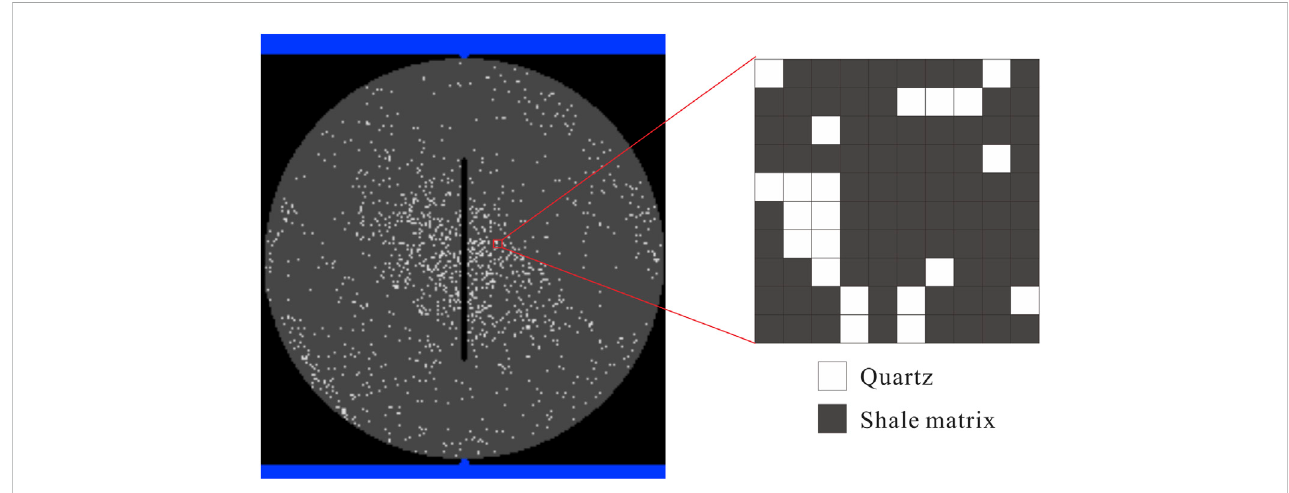
FIGURE 4 Image after threshold